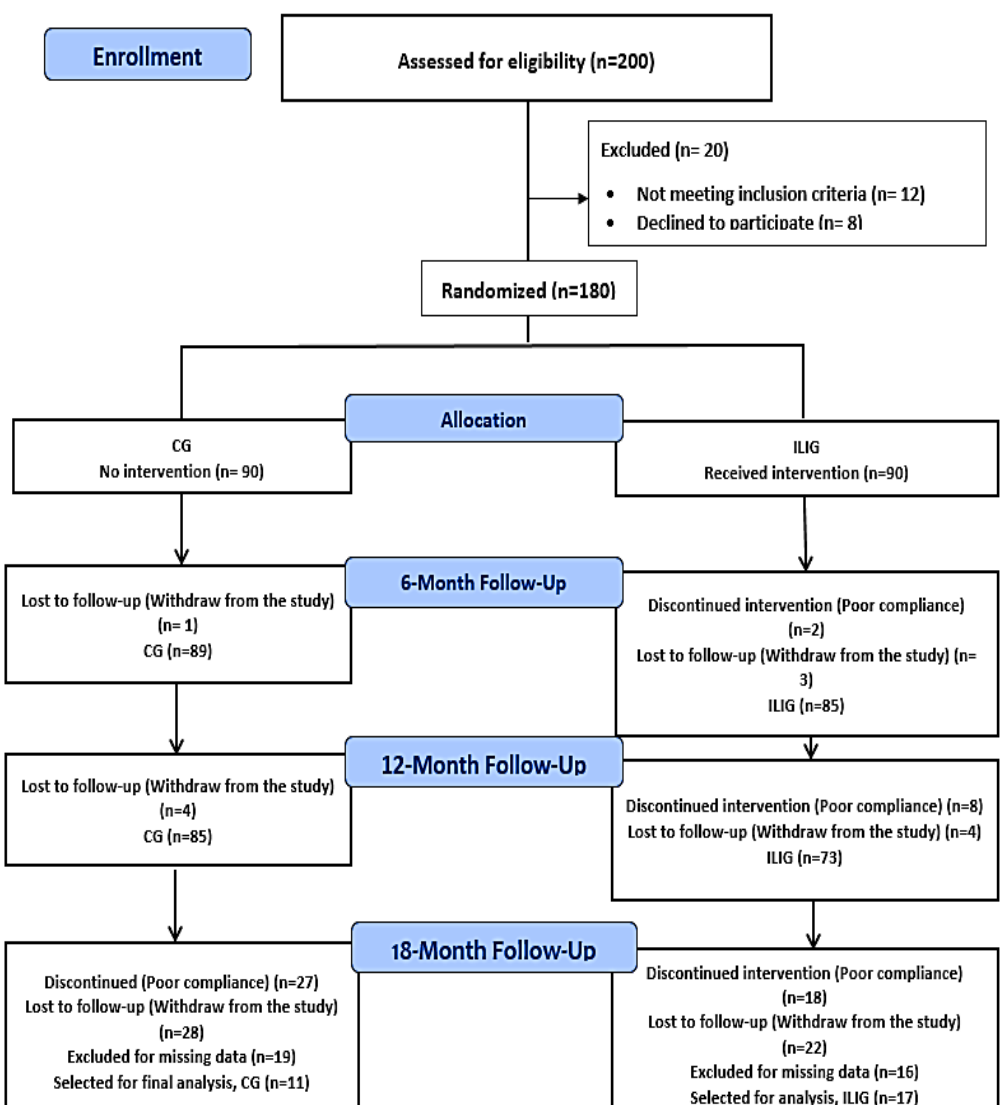
Figure 1. Flow chart of the study participants describing their participation and allocation (CG, control group; ILIG, intensive lifestyle intervention group).